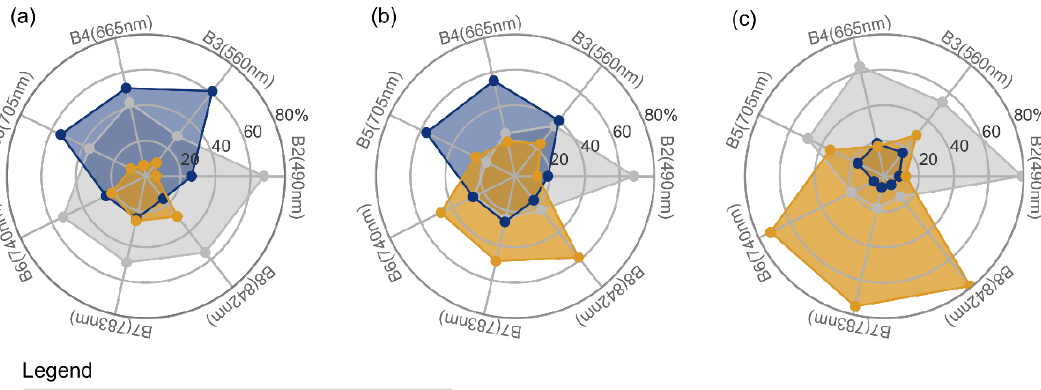
Figure 9. Contribution to the TOA of the reflectance values of water bodies, atmosphere, and adjacency effects in ( a ) eutrophic, ( b ) bright, and ( c ) dark waters. The TOA signal was modeled with 6SV using input data from Appendix B (Table A1). For the water contribution, we used in-situ measurements. Adjacency effect was estimated assuming the H Adj described in Figure 4 (AWP-Inland Water algorithm).